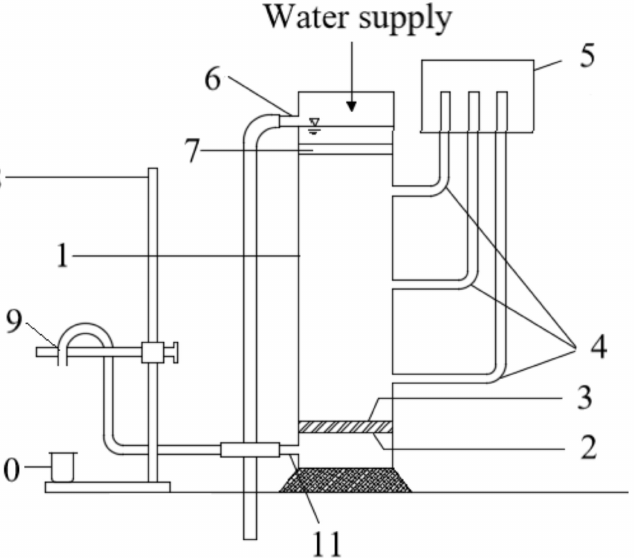
Figure 1. Schematic diagram of the experimental device. 1. Tank 2. Metal plate with holes 3. Metal mesh 4. Pressure hole 5. Pressure measuring tube. 6. Overflow hole 7. Glass ball, 8. Iron frame 9. Outlet pipe 10. Beaker 11. Outlet